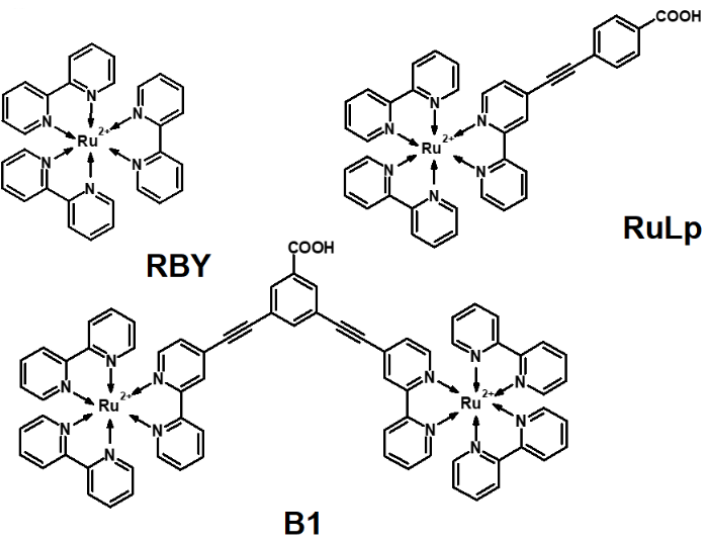
Figure 1. The molecular structures of Ru(II)